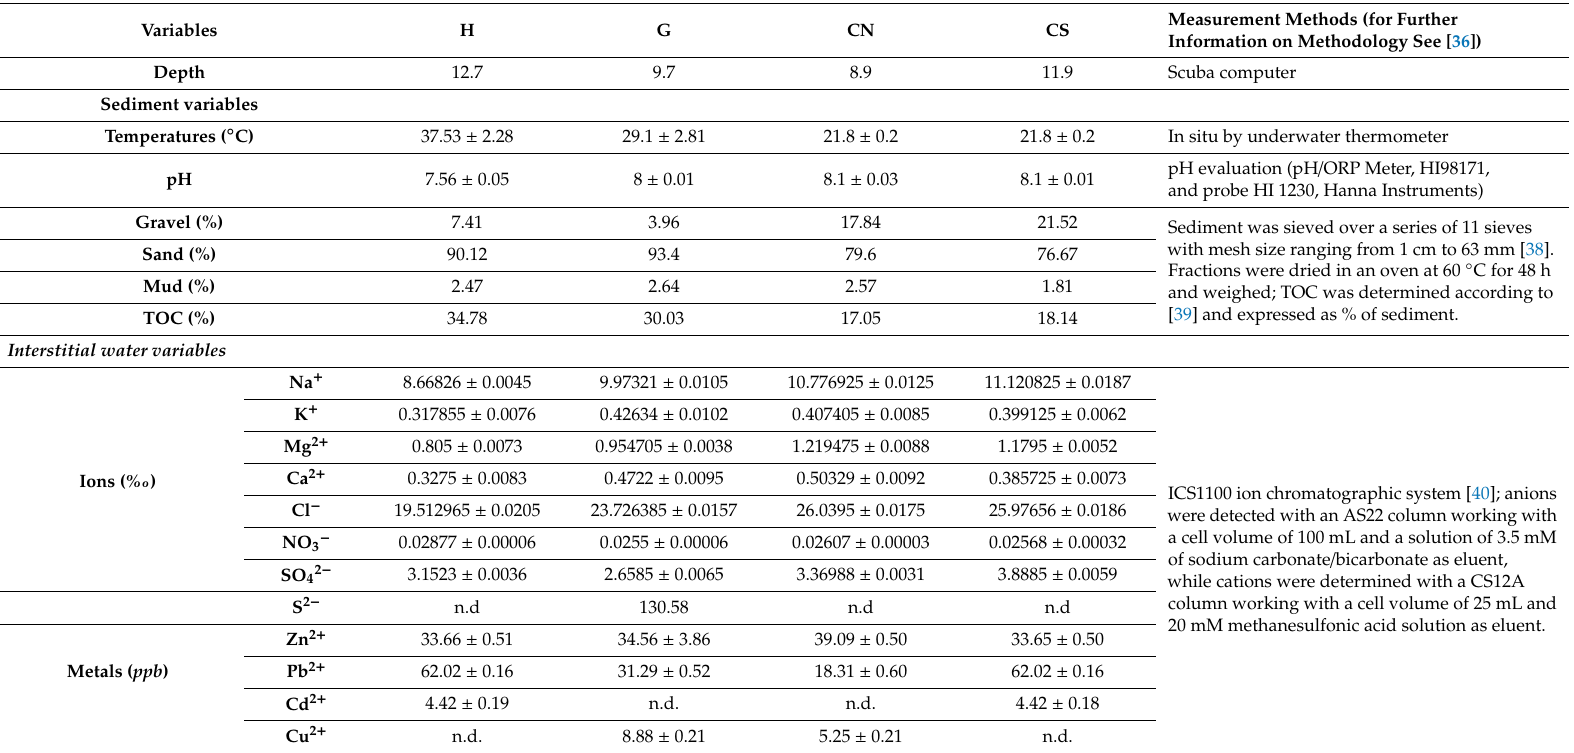
Table 1. Environmental parameters detected in each of the sampling sites: H—carbon dioxide hydrothermal vents, G—Geyser with sulfurous deposits, CN and CS—control / inactive sites respectively at the north and at the south of the study